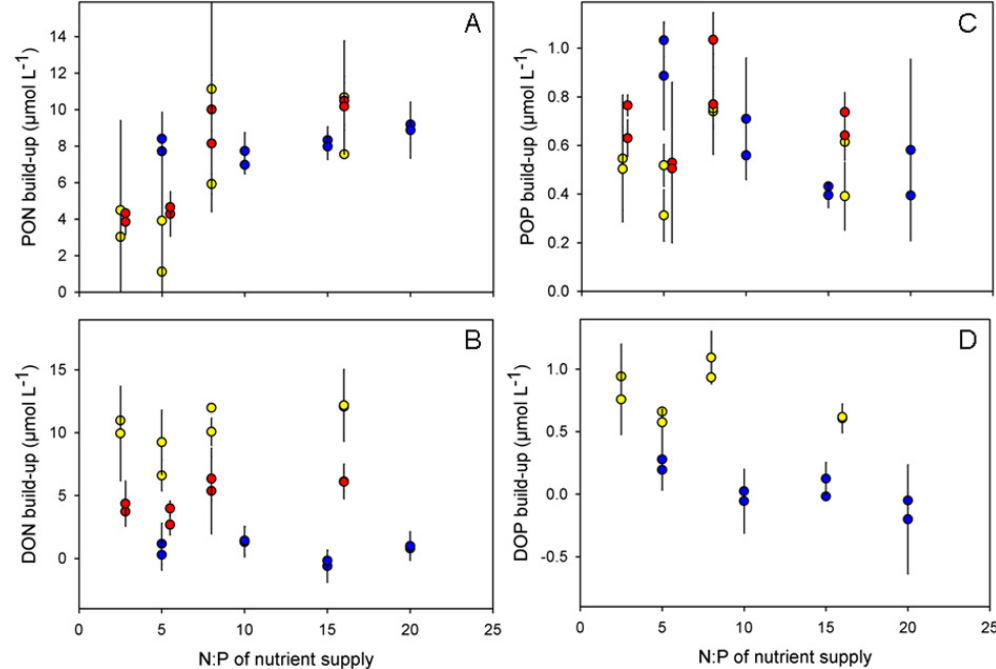
Fig. 8. Build-up of (A) PON, (B) DON, (C) POP and (D) DOP until day one and two after DIN limitation as a function of N : P stoichiometry of the supplied nutrients during three (PON, DON, POP) or two experiments (DOP). Style and colour-coding according to Fig.